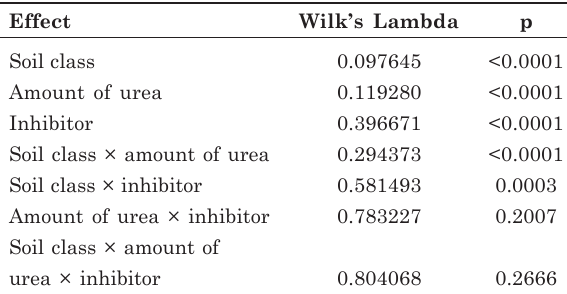
table 6. A significant effect of the soil class × amount